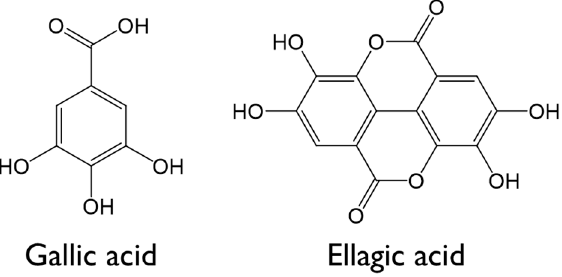
Figure 1. Structures of the main coloring components of T. chebula dye.